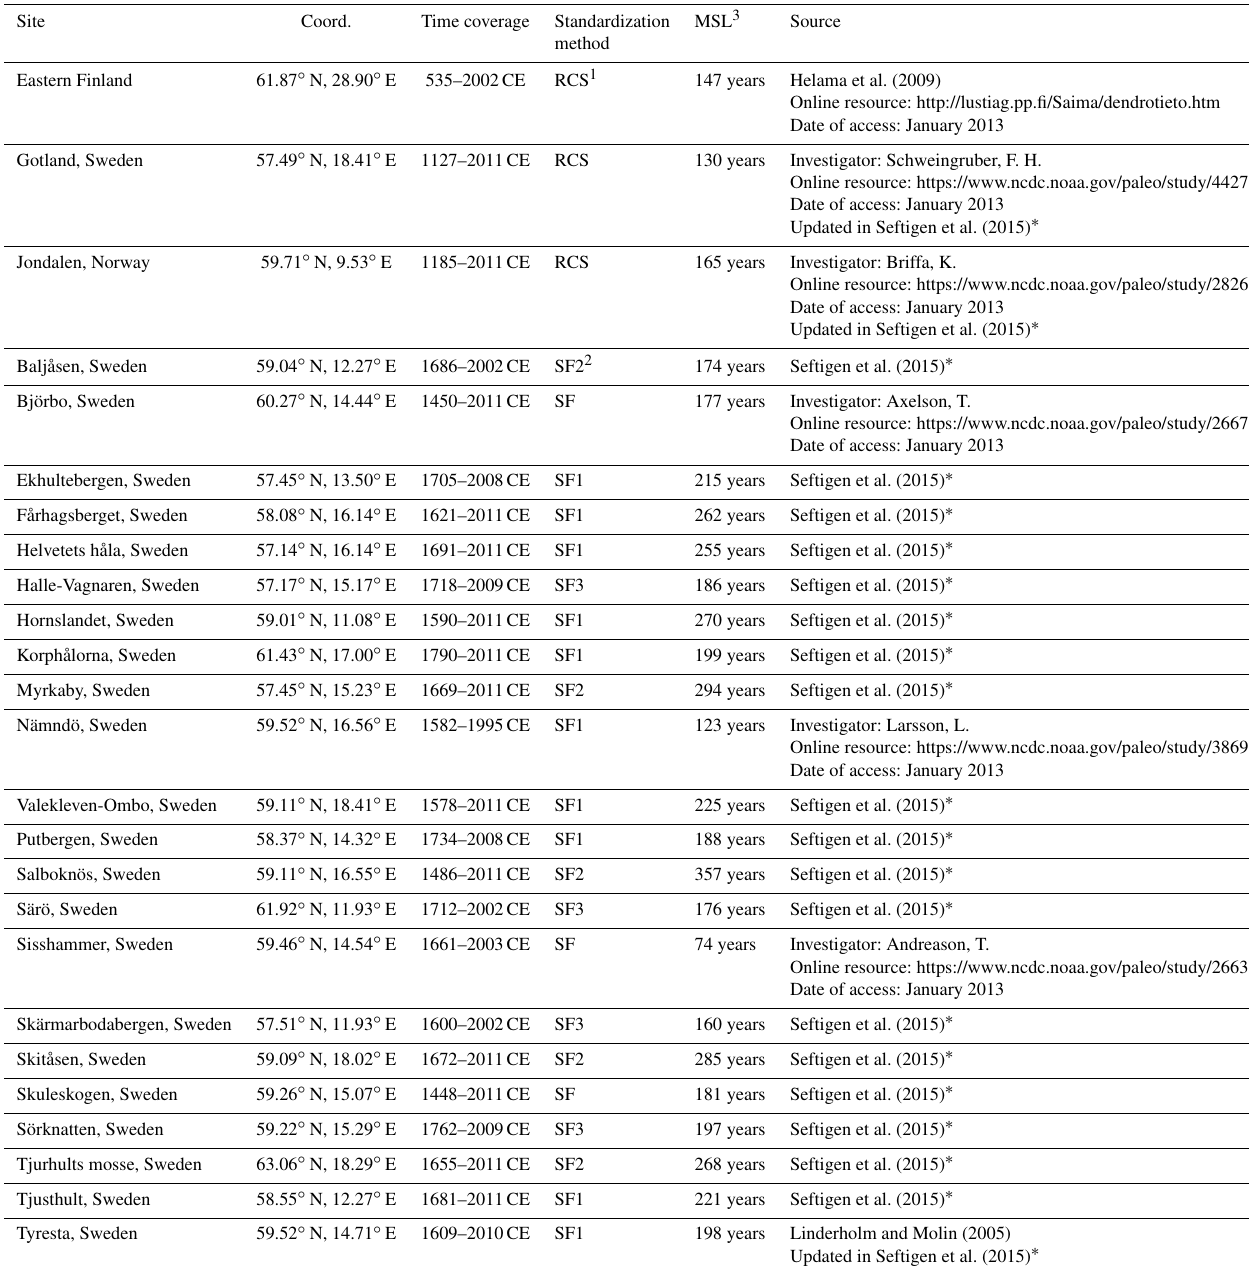
Table 2. Tree-ring network description.